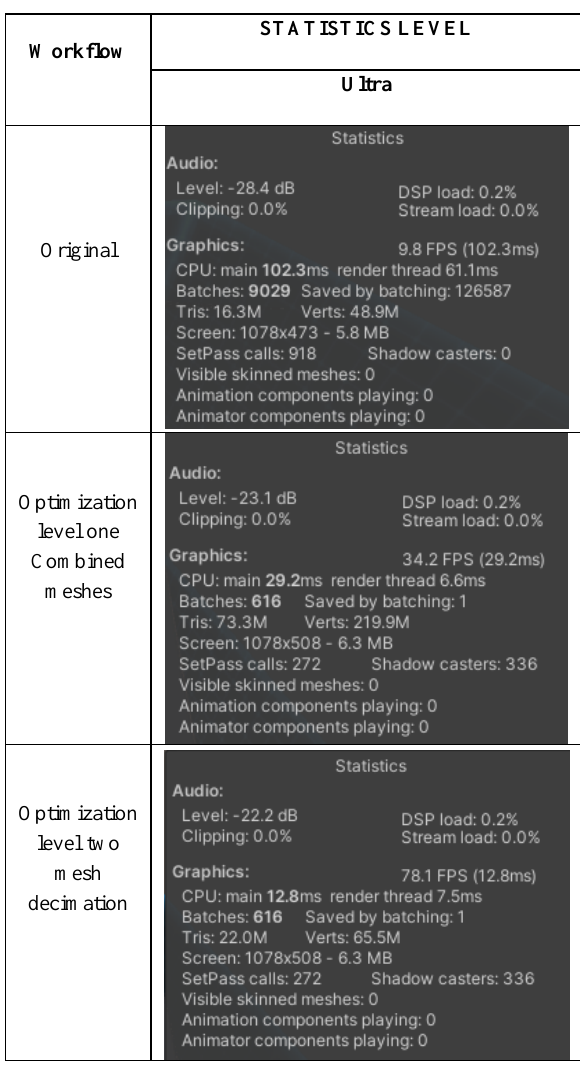
Table 2 . Improved workflow statistics.